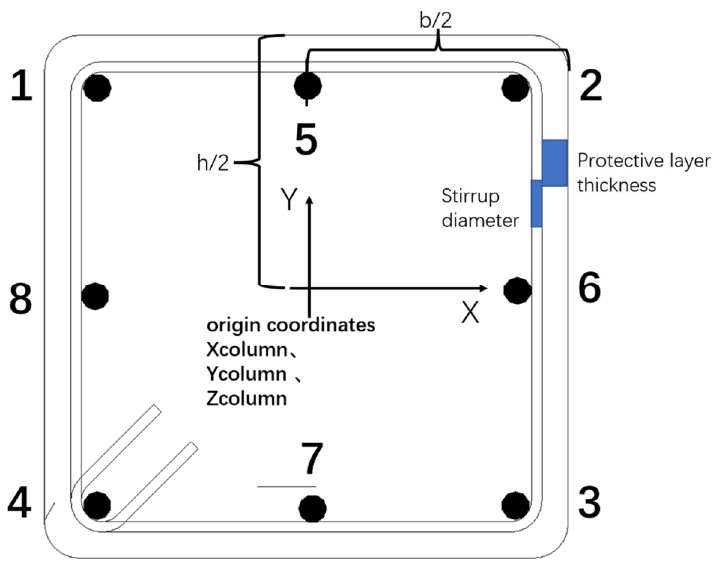
Figure 4. Schematic diagram of the calculation of the longitudinal rebar position coordinates.